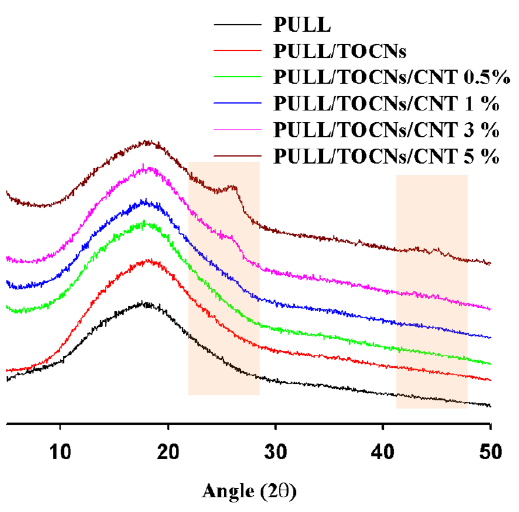
Figure 4. XRD data of the neat PULL and PULL/TOCNs/CNT (0 – 5 wt.%) composite film.